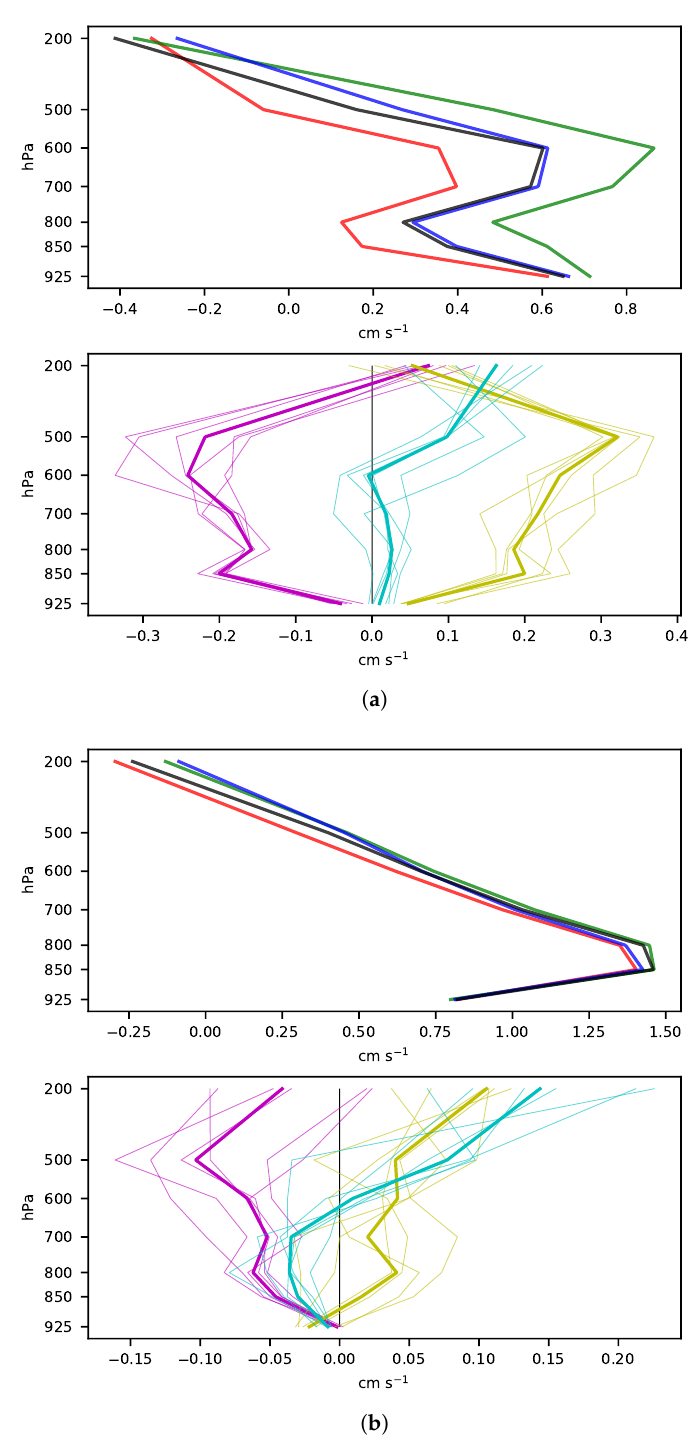
Figure 10. Guinea ( a ) and Sahel ( b ) regional mean JAS vertical wind speed for the control and sensitivity experiments ( top ) and anomalies ( bottom ). The velocity units is in cm s − 1 meaning that positive (negative) values are oriented upward (downward). Thick lines are study period median values and thin lines are individual